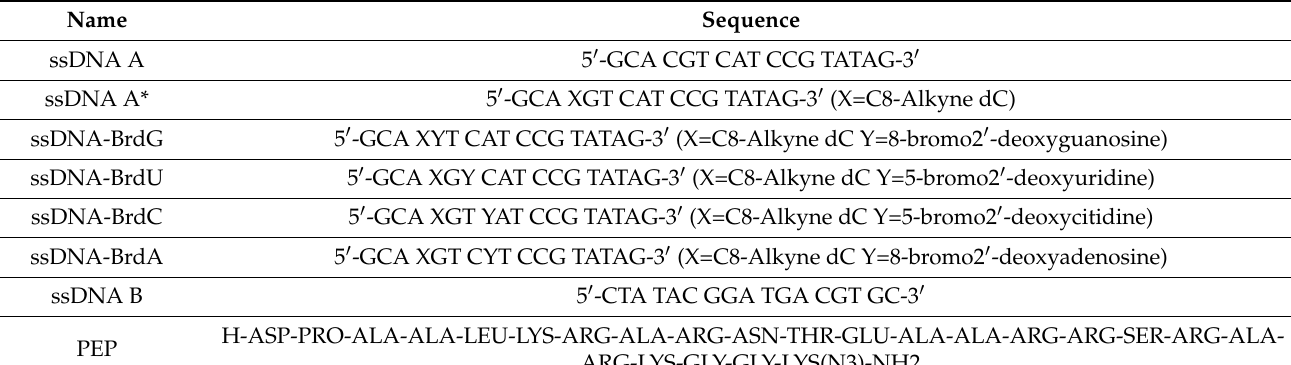
Table 2. The list of the oligonucleotides and peptide sequences with their respective abbreviations. Name Sequence